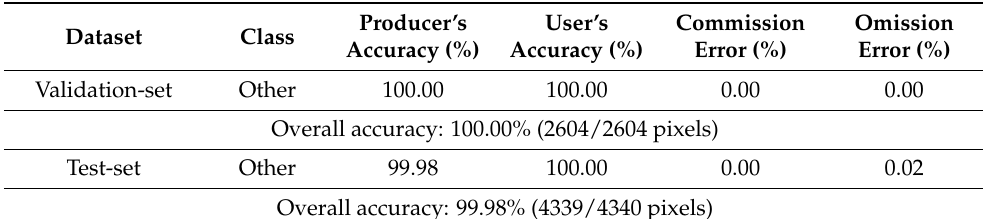
Table A2. Confusion matrix of the validation and test dataset for the Others class classification model applied to 2018